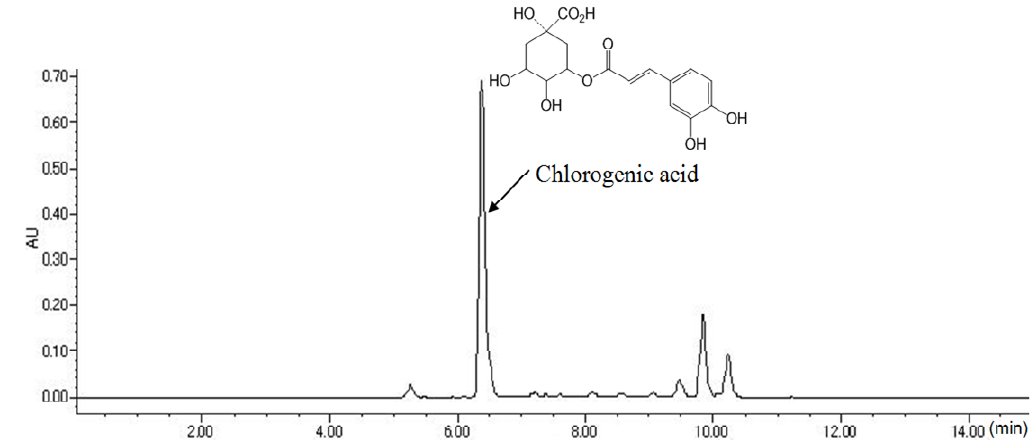
Figure 1. HPLC profile of “Kin-gin-ka” (flower buds of Lonicera japonica Thunb.) extract. Contents of chlorogenic acid was calculated on the basis of a standard curve (y = 13122194.8x + 1709916, r 2 = 0.9902) within a certain concentration range (0.021–2.10